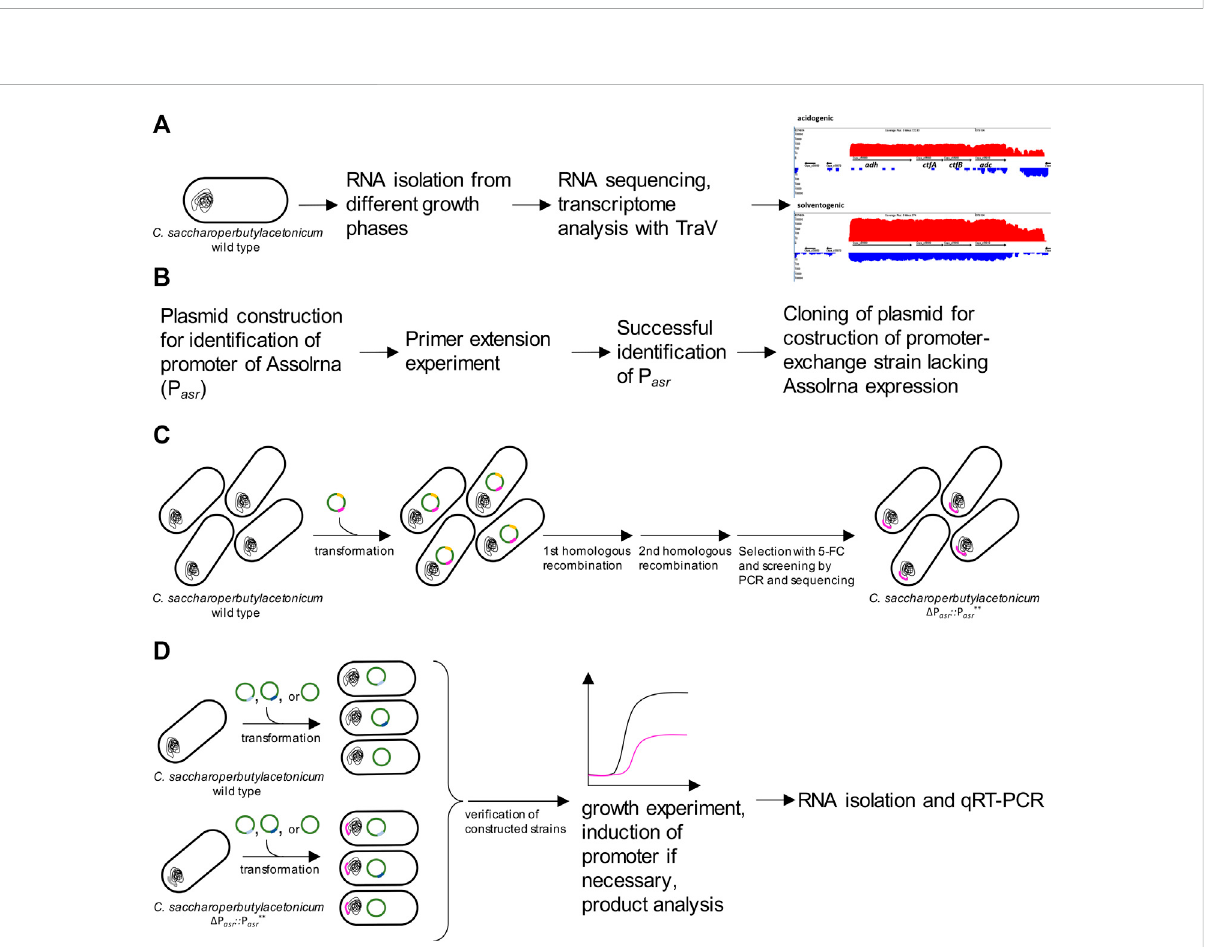
FIGURE 2 Overviewofdifferentexperimentsconductedinthisstudy. (A) identi fi cationofAssolrnausingTraV ’ s “ antisensetranscriptsearch ” algorithm(red showingtranscriptsof+strand,blueshowingtranscriptsof — strand); (B) stepsperformedforidenti fi cationofpromoterofAssolrna; (C) ,construction of C. saccharoperbutylacetonicum Δ P asr :: P asr ** using the plasmid pMTL-PromoterRNA harboring homologous regions from upstream and downstreamoftheidenti fi edP asr promoterandamodi fi edsequenceforthepromoterregion(P asr **)(pink)aswellas codA (yellow)asselection marker for 5- fl uorocytosine (5-FC); (D) construction of plasmid based overexpression, complementation, and control strains (bright blue